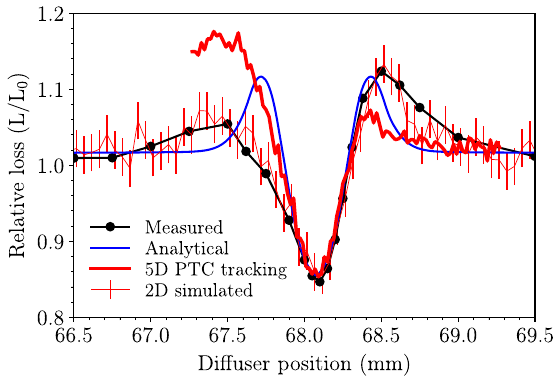
FIG. 13. Comparison of 400 GeV =c measured normalized sum of extraction BLM loss to simulated and analytical losses for a 260 μ m Ta diffuser with 10 12 protons per